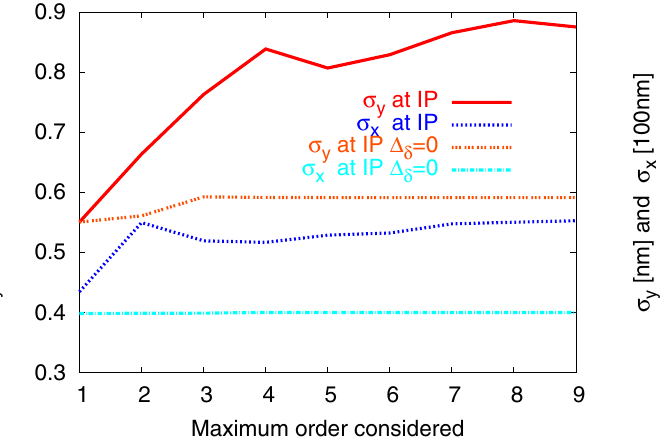
FIG. 2. (Color) Horizontal and vertical rms beam sizes at the CLIC interaction point as a function of the maximum order considered in the transfer map. Both the nominal and mono- chromatic beams are considered. The horizontal aberrations are purely chromatic and only a small part of the vertical aberrations are beam sizes is to consider the collimation section and the final focus separately.